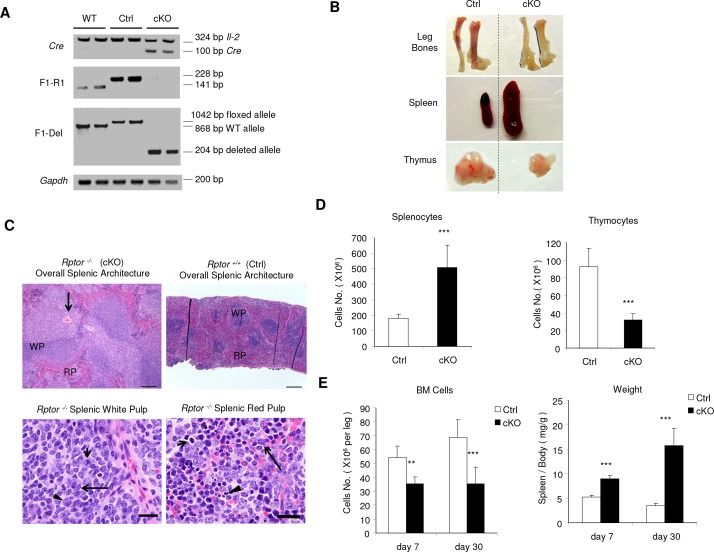
Conditional deletion of Rptor resulted in abnormal hematopoiesis.(A) Deletion of Rptor in BM cells. PCR were performed to check the deletion in BM from mice 2 weeks after pIpC treatment (for Ctrl and cKO mice, no treatment for WT mice). (B) Representative pictures of leg bones (tibiae and femurs), spleen, and thymus harvested from mice on day 30 post pIpC treatment. (C) Histology findings in the cKO spleen by H&E staining. Up left panel: a spleen histological section showing expanded white pulp areas (WP) and compressed intervening red pulp (RP). The white pulp contains an increased population of lightly staining cells that sometimes is situated in the marginal zones and follicular centers (B cell areas) and sometimes infiltrates the periarteriolar sheaths (T cell area, long arrow). Up right panel: normal splenic architecture from control mouse. Scale bar, 200 μm. Down left panel: higher magnification of expanded cell population within the splenic white pulp. Morphologically these cells resemble germinal center lymphocytes. There are both smaller cells with cleaved nuclei (long arrow) resembling centrocytes and larger cells with 1–2 prominent nucleoli resembling centroblasts (short arrow). There are small numbers of plasmacytoid cells (arrowhead). Down right panel: histological section of splenic red pulp Red pulp of the spleen showing foci of extramedullary hematopoiesis with decreased erythroid (short arrow) and myeloid (long arrow) progenitors. The erythroid lineage contains occasional foci of pyknotic or karyorrhectic (fragmented) nuclei consistent with cell death (asterisk). Scale bar, 20 μm. (D) The cellularities of splenocytes (left) and thymocytes (right) from mice at day 30 post pIpC treatment. n = 6 for Ctrl mice; n = 5 for cKO mice. (E) BM cellularities (left) and spleen/body weight ratios (right) for mice on day 7 and day 30 after pIpC treatment. n = 3 ~ 8 for Ctrl mice; n = 5 ~ 6 for cKO mice.